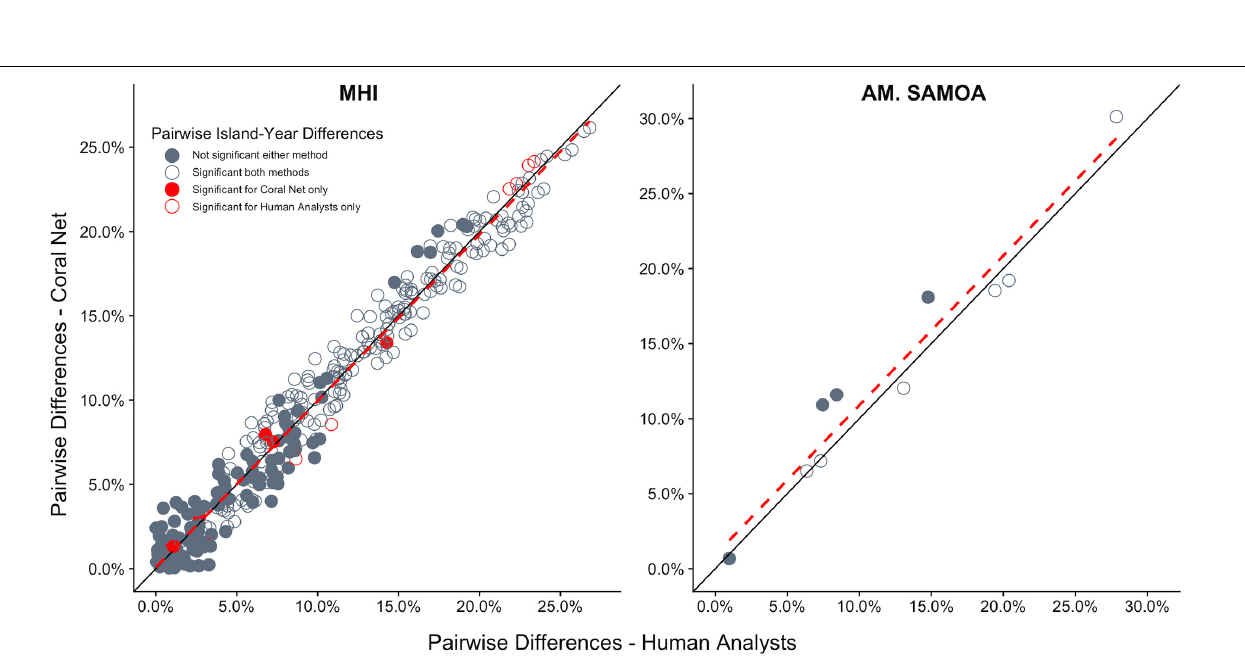
FIGURE 8 | Difference in cover between all island-year pairs for human-analyst and CoralNet. Each point represents one island-year pair (325 pairs in MHI, 10 for American Samoa). The black solid-line represent the 1:1 – i.e., difference in cover between island-years was identical for the two methods. The red hatched line is a linear fit of the points. Points shown in dark gray are cases where human-analyst and CoralNet produced the same statistical result. The 15 red points in MHI are cases where there was a difference in statistical outcome depending on the annotation method used. Solid circles represent island-year pairs for which human-analyst cover estimates did not significantly differ, and empty circles where the difference was